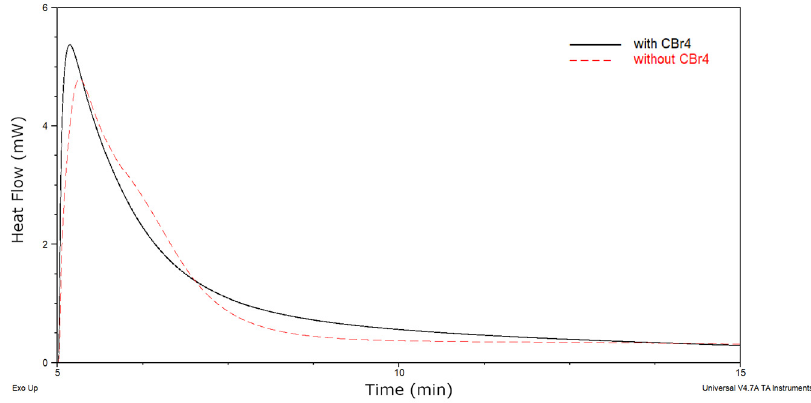
Figure 2. UV-induced cotelomerization curves for monomers compositions (BA—94 wt %, AA—5 wt %, ABP-1 wt % and TPOL-0.1 phr) with CBr 4 (2.5 phr) and without CBr 4 (I o = 15 mW/cm 2 and 320–390 nm).